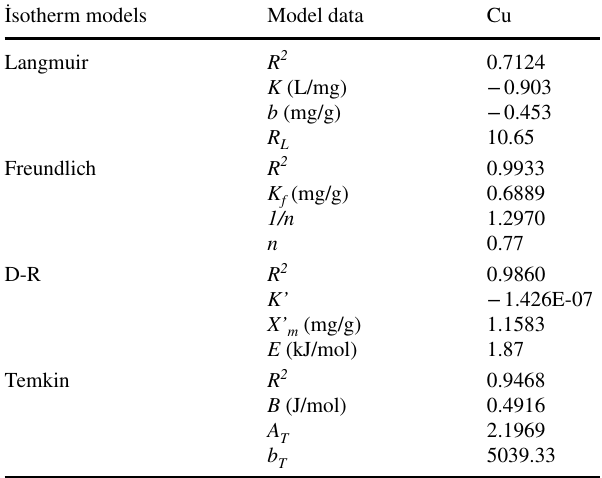
Table 1 Model data for adsorption isotherms İsotherm